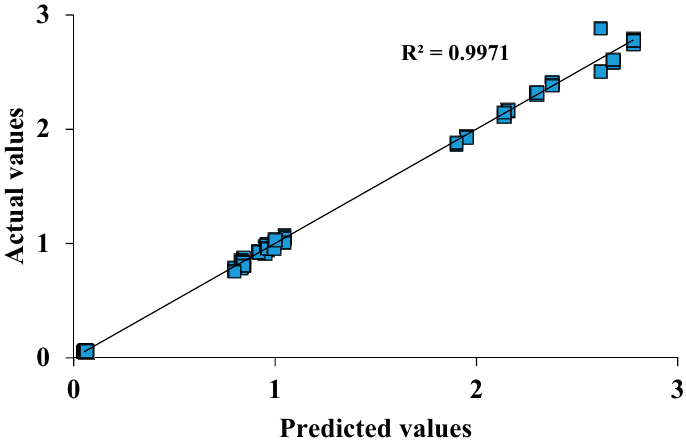
Figure 6. A linear plot estimating accuracy of a regression model by comparing actual versus predicted data sets. The plot determines the correlation between the model’s predictions and actual data and thereby indicates how well the model fits the data. The closer the value of R 2 is to 1, the better the fit of the line to the data and the goodness of the model.